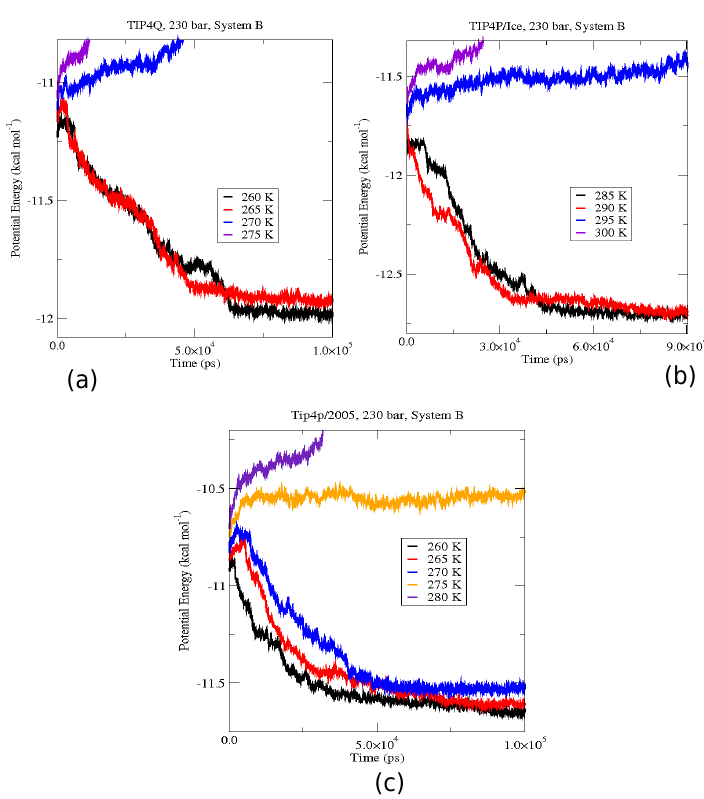
Figure 9. Evolution of the potential energy at a fixed pressure of 230 bar for system B. ( a ) Shows the results for TIP4Q; the three-phases coexistence temperature calculated was 267.5 K (+/ − 2.5 K); ( b ) Shows the results for TIP4P/Ice; the three-phases coexistence temperature calculated was 292.5 K (+/ − 2.5 K); ( c ) Shows the results for TIP4P/2005; the three-phases coexistence temperature calculated was 272.5 K (+/ − 2.5